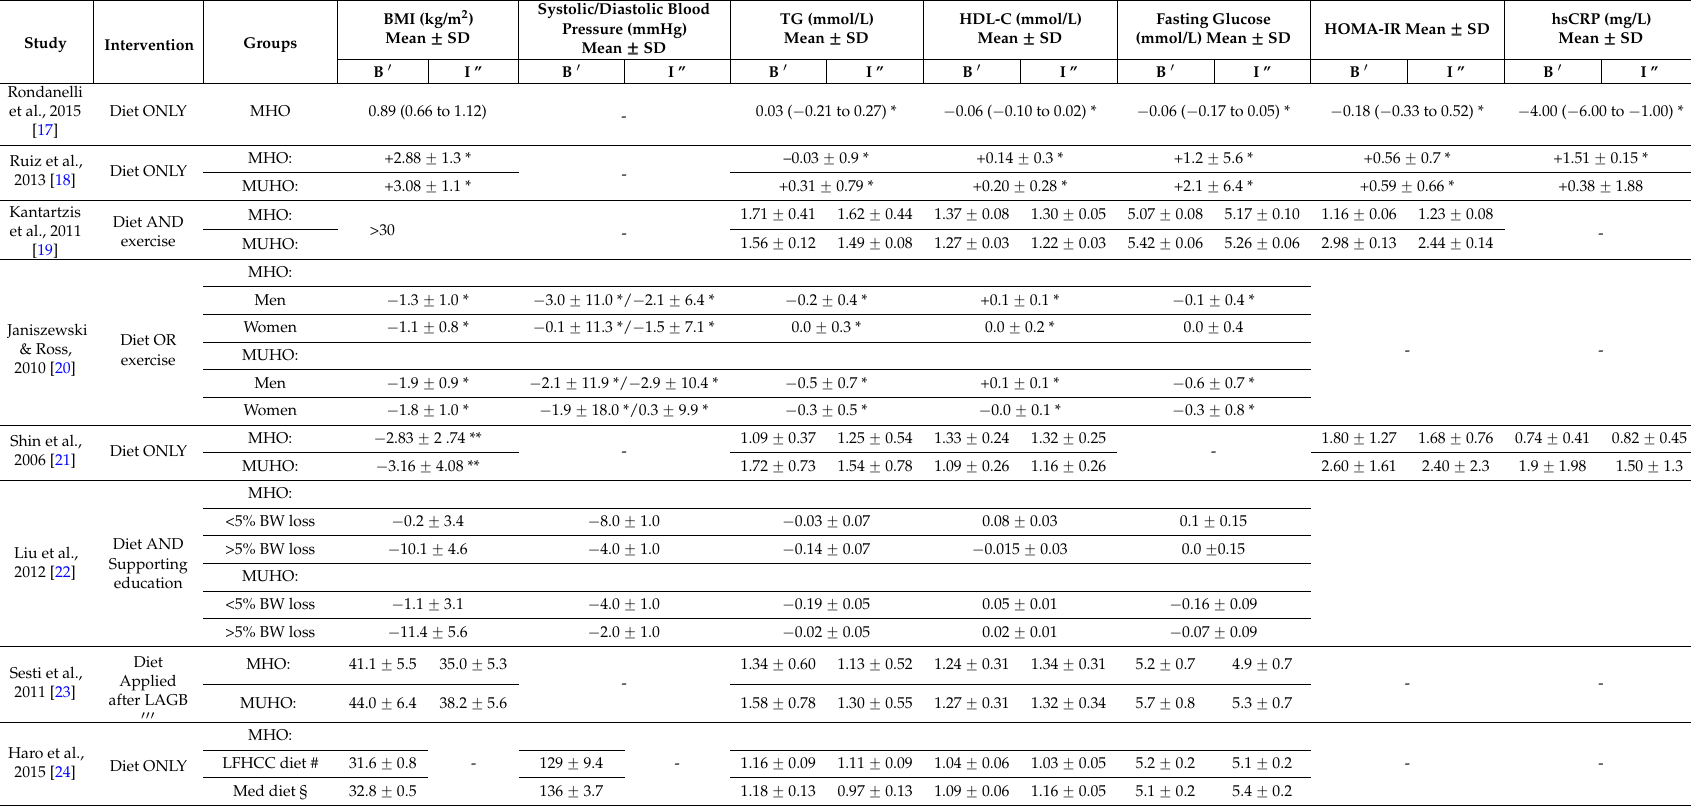
Table 2. Changes in Body Mass Index and parameters describing cardio-metabolic outcomes in metabolically healthy